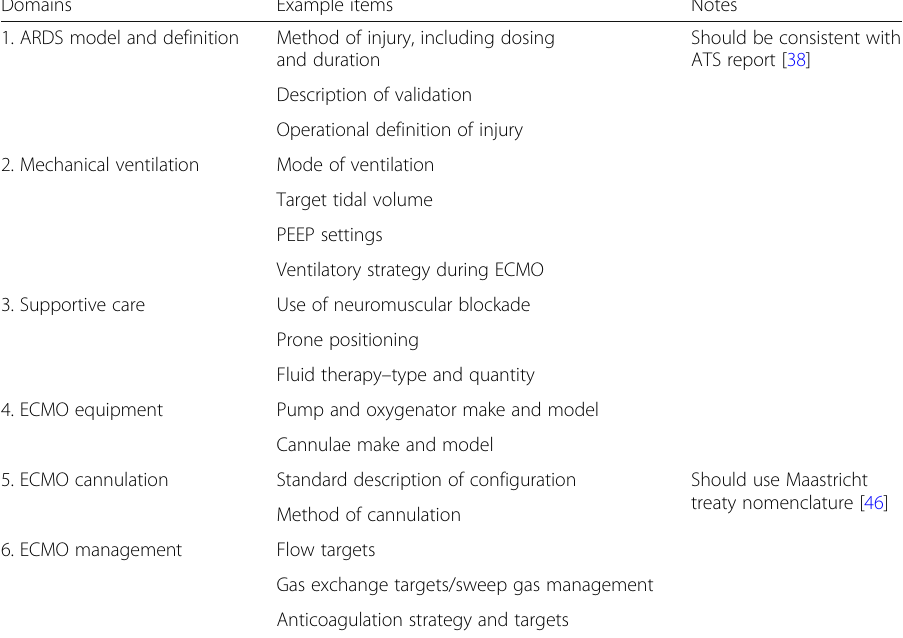
Table 6 Proposed domains of a minimum reporting standard for pre-clinical studies of ARDS and ECMO